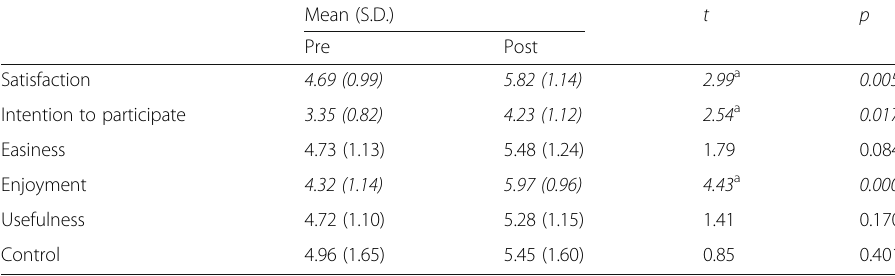
Table 6 Testing the effect of interactive displays activity of students ’ engagement Mean (S.D.)